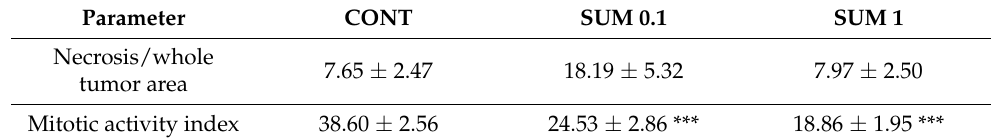
Data are expressed as mean ± SEM. Significant difference, *** p < 0.001 vs. CONT.